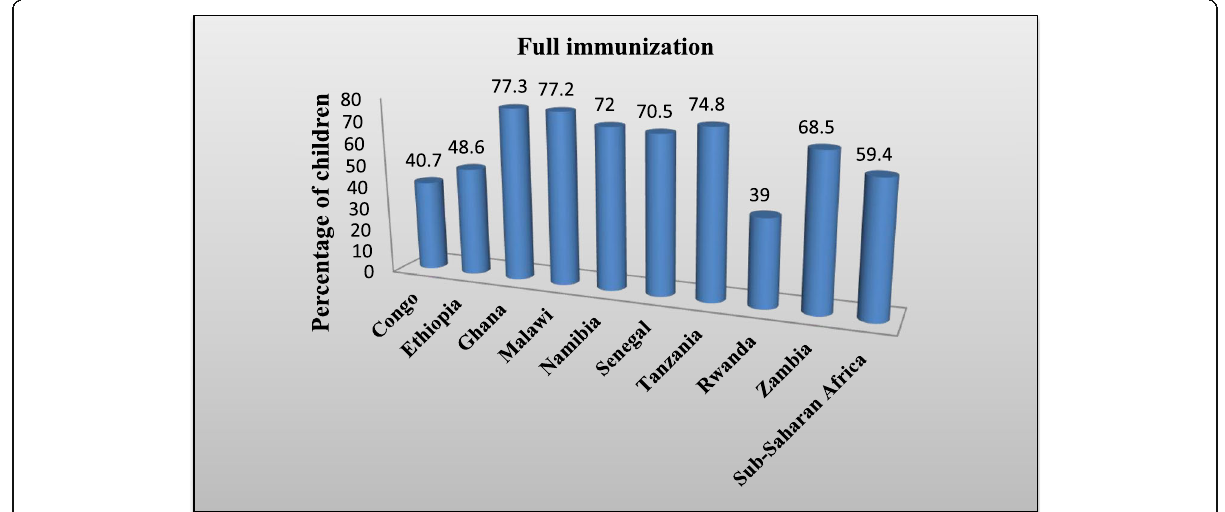
Fig. 1 Prevalence of full immunization in sub-Saharan African